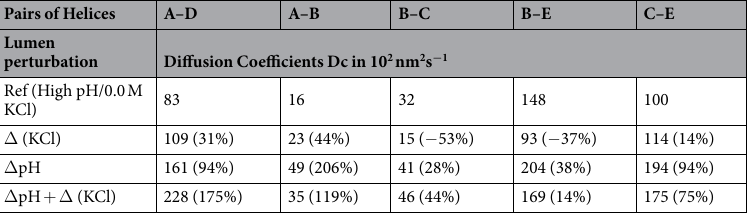
Table 1. The average diffusion coefficients D C in 10 2 nm 2 s − 1 between the center of masses of the LHC helices in pairs (major from spinach-pea and minor CP29 from spinach). The values are based on the linear fit of the Mean Square Displacement (MSD) profiles versus time (t) in Fig. 2S (in SI) and the Einstein relation MSD = 6 * D * t + c, where “c” is a constant. The % changes in D C values are also shown in parentheses based on the lowest energization sample (termed